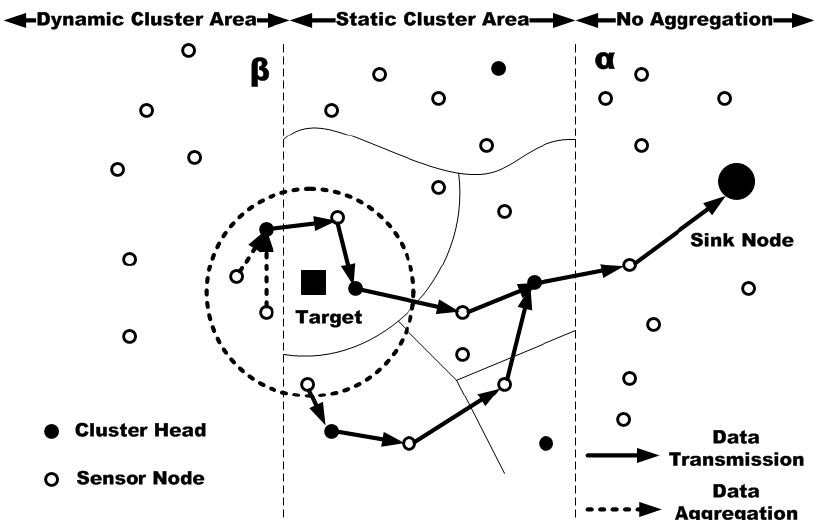
Figure 3. Combined Clustering-based data